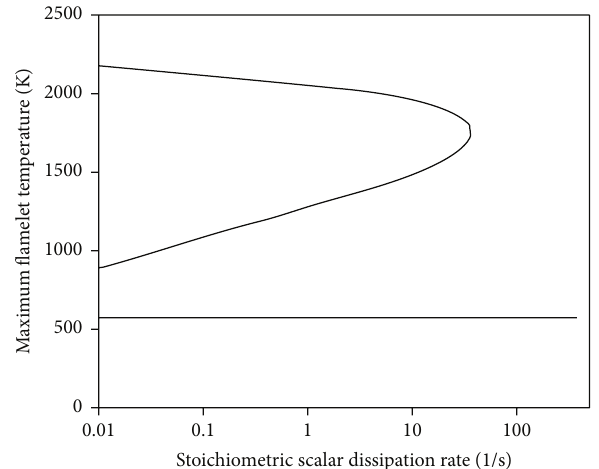
Figure 3: S-shaped curve for the NG-FGR20 flame.